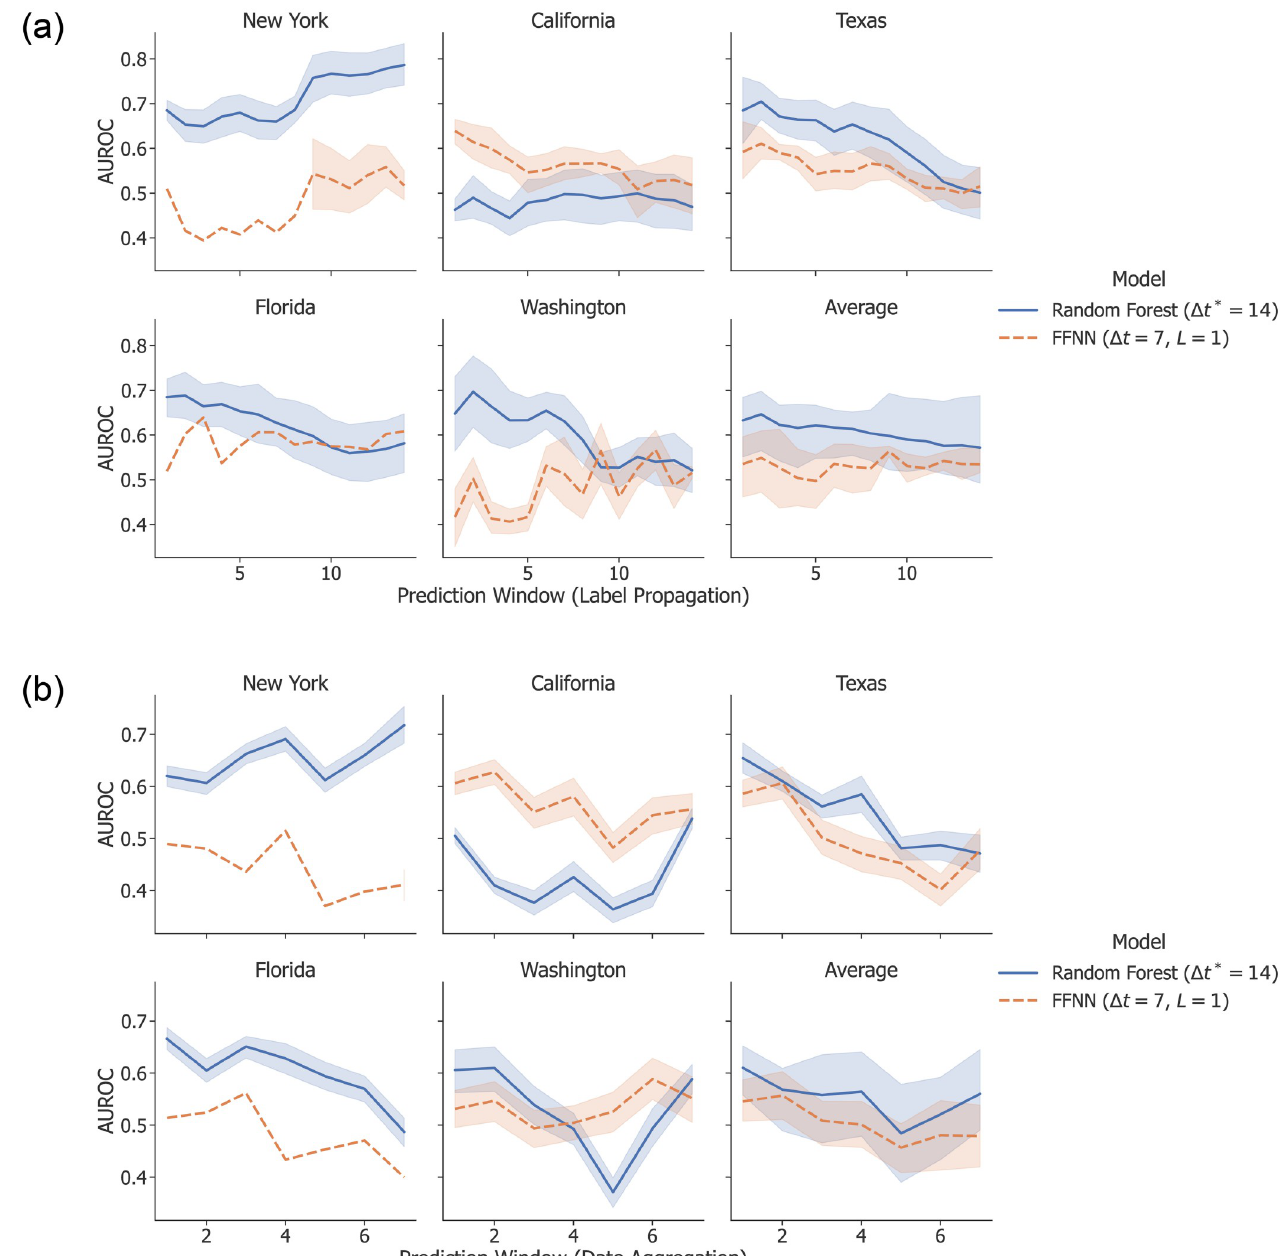
Fig 8. Classification performance for models using larger prediction windows. The performance of both label propagation (top) and date aggregation (bottom) suggests that using coarser date representations hinders the models’ ability to discriminate between classes. In each plot, AUROC is shown as a function of Δ p (the prediction window) for the given state. Shaded regions represent the standard deviation across testing